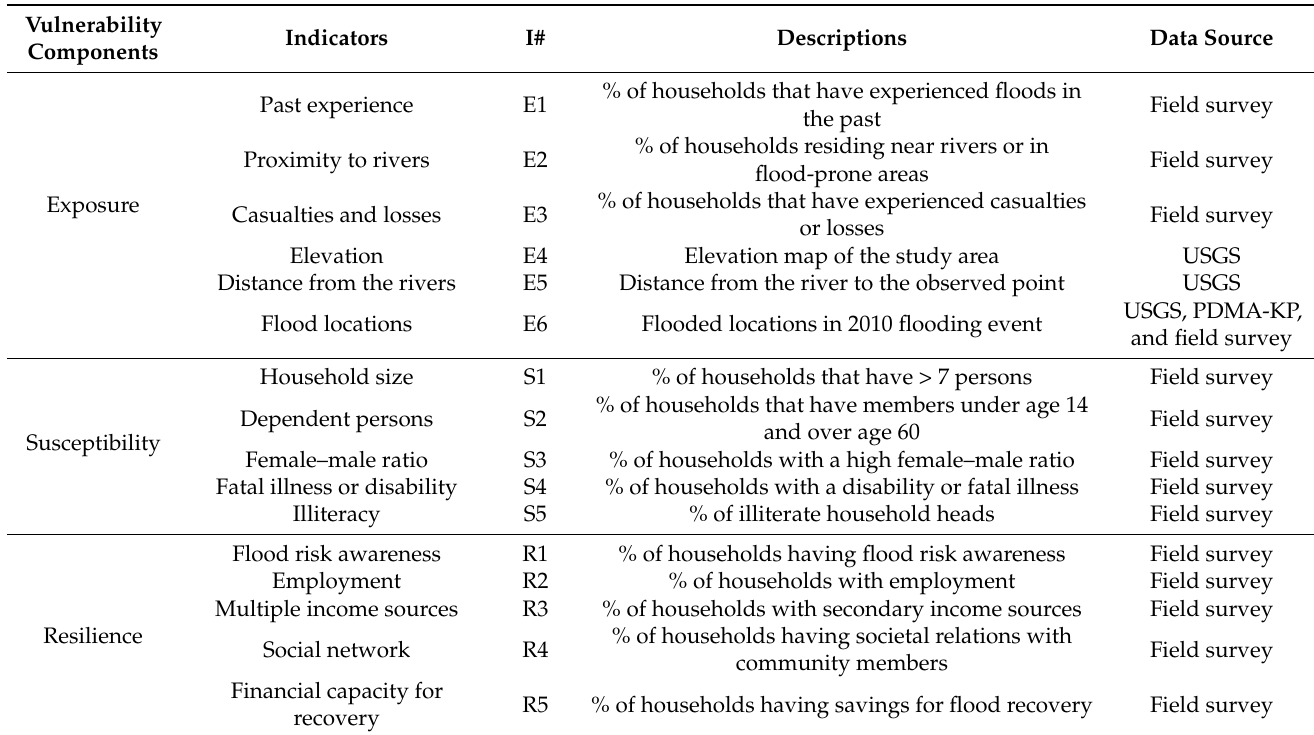
Table 1. Indicators for measuring